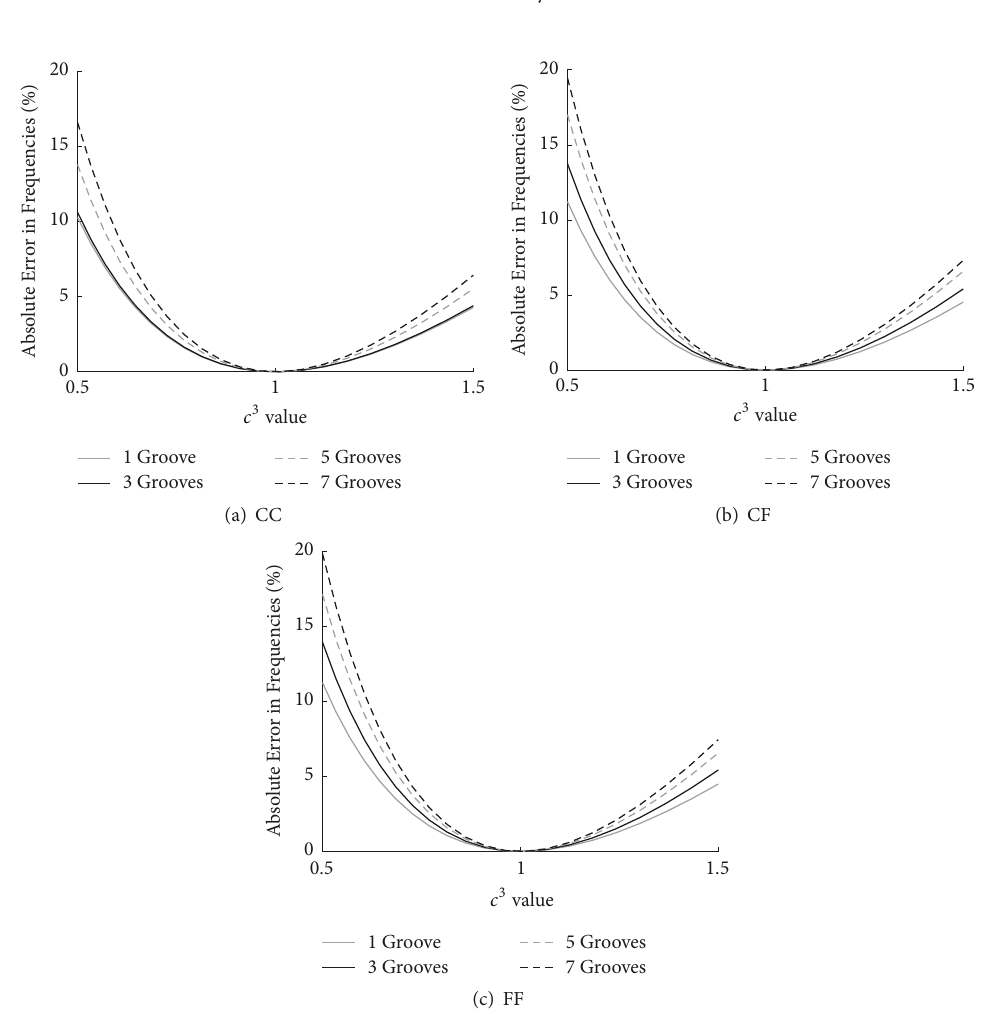
Figure 8: Frequency error results for variable 𝑐 using the first-order gradient